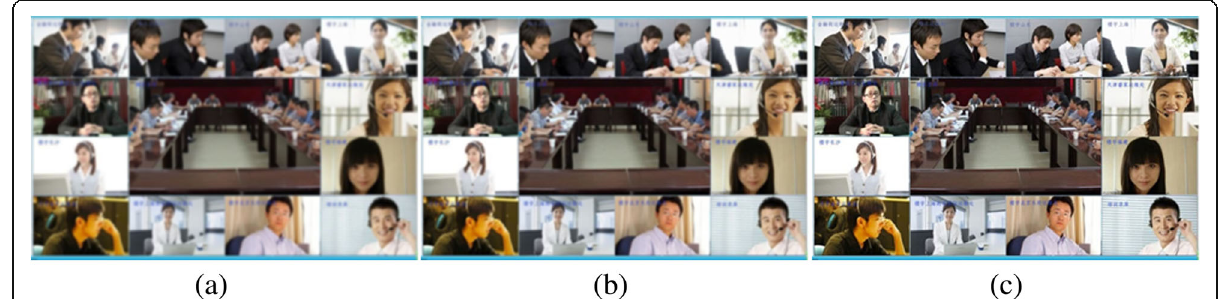
Fig. 7 Comparison of image correction